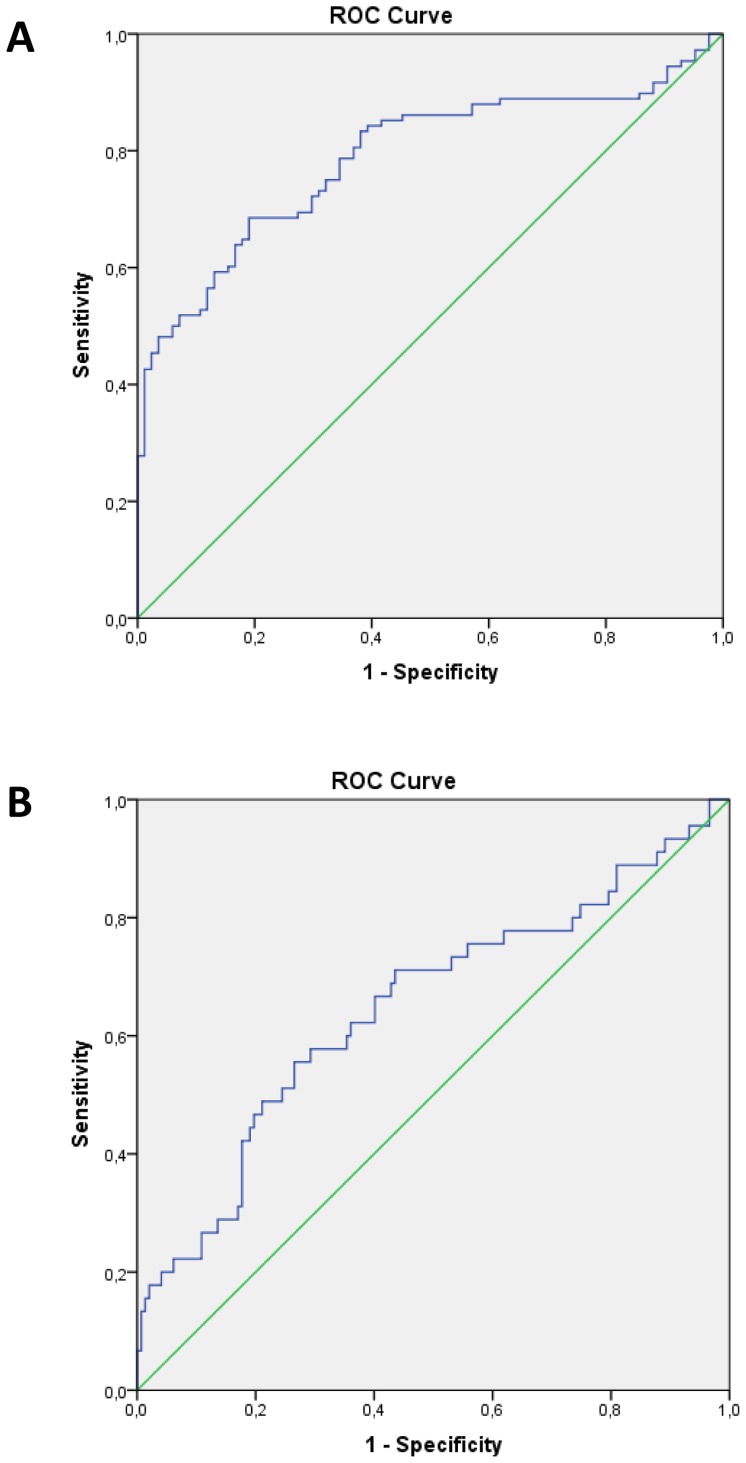
ROC-curves for analysis of sensitivity/specificity ratio to evaluate diagnostic significance of integral mutation burden of mtDNA, when the presence of any atherosclerotic plaque in any visualized carotid segment (A), or the presence of CHD (B) are taken as actual states.Integral mutation burden is calculated by using logistic regression model, which predicted the probability of belonging to a particular category (the predictors are the levels of heteroplasmy for C3256T, T3336C, G12315A, G13513A, G14459A, G14846A, and G15059A mutations).